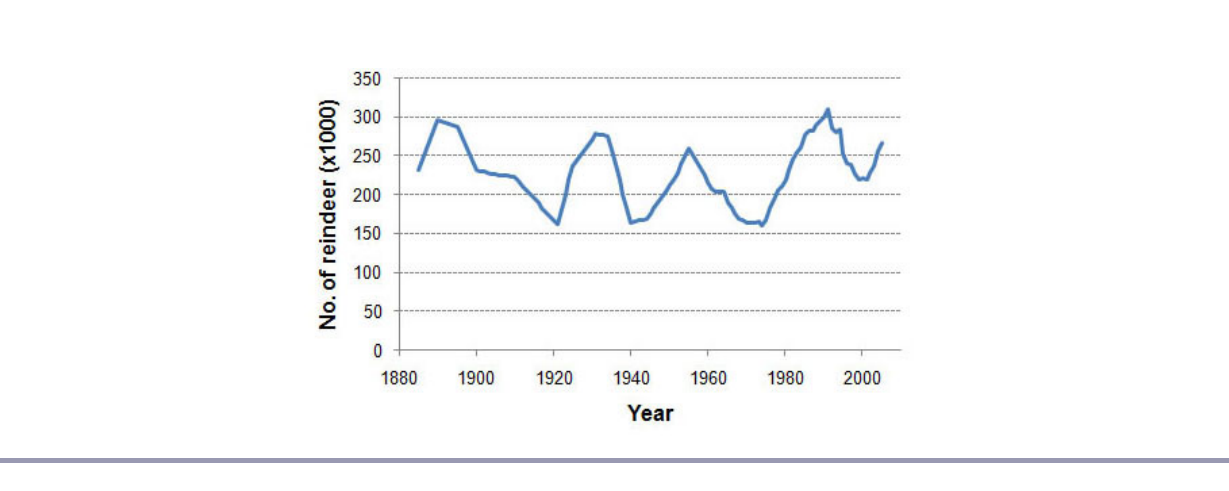
Fig. 1 . Number of reindeer in the Swedish reindeer husbandry area. The number is given as the size of the winter herd. Data from Moen & Danell (2003) and the Sami Parliament official statistics (http://